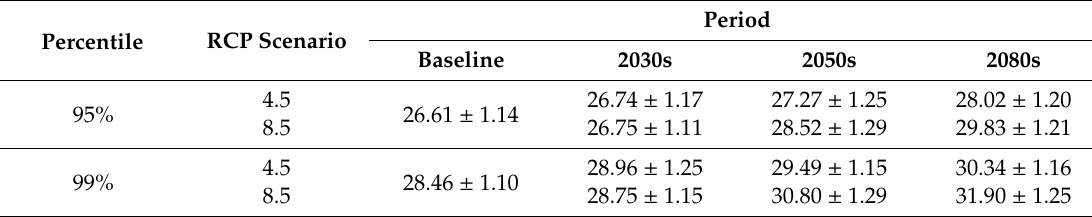
Table 1. The 95th and 99th percentile temperatures for the 229 districts in South Korea at baseline and in the projected periods (2030s, 2050s, and 2080s).